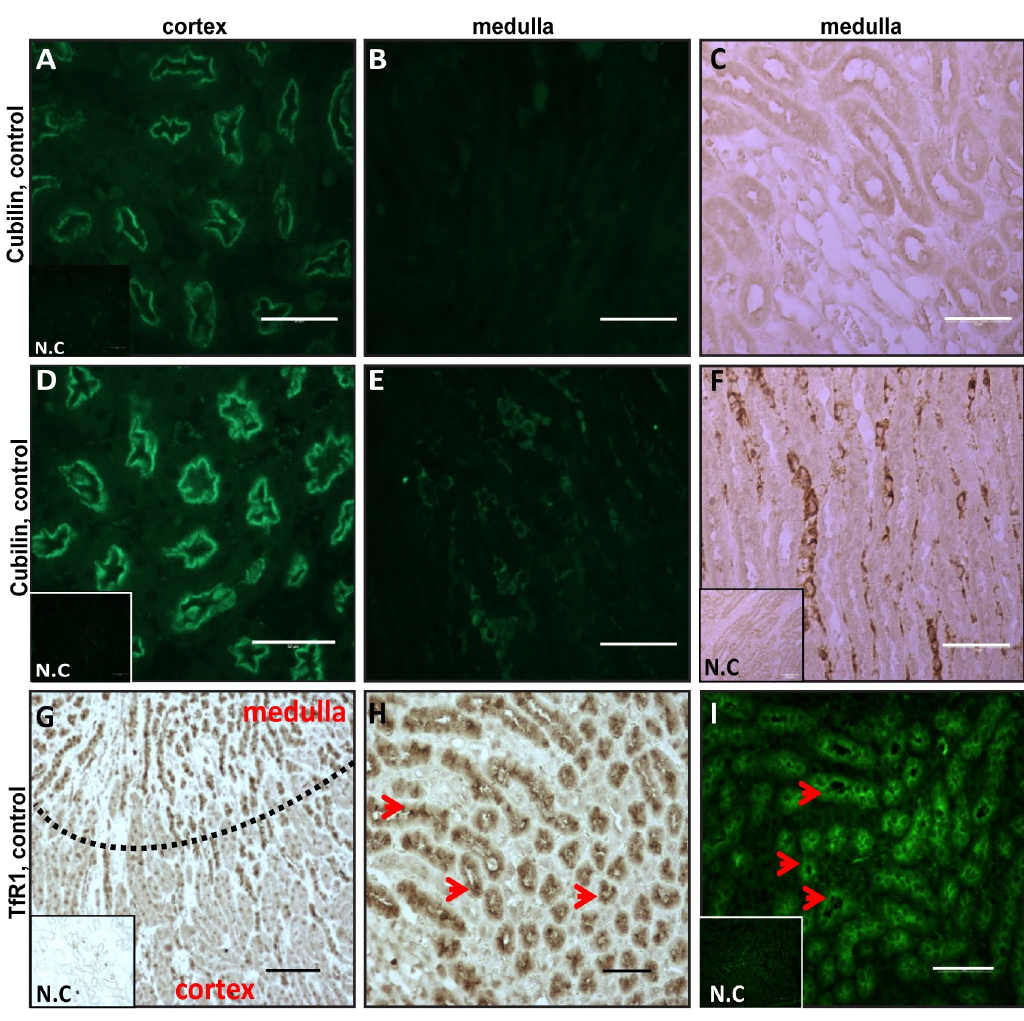
Fig 2. Cubilin expression in iron loaded kidneys is elevated both in the cortex and the medulla. The fixed kidney sections were incubated with cubilin or TfR1 antibodies and stained by IF or IHC. (A-F) Cubilin was observed apically in the cortex, as expected, with increased staining in kidneys from iron overloaded mice (compare A to D ). Interestingly, in PIO, significant cubilin expression was also observed in the medulla (compare B to E , and C to F ). Inserts are negative controls (N.C) for cubilin staining; (G-I) Visualization of TfR1 by IHC (G-H) and by IF (I) . (G) TfR1 staining was seen mainly in the medulla, (the dashed line separates the cortex from the medulla. In the medulla, TfR1 was seen apically (H-I) (indicated by arrows). Inserts are negative controls (N.C) for TfR1 staining; scale bar of 50 μ m, n = 3 for control and iron-loaded mice